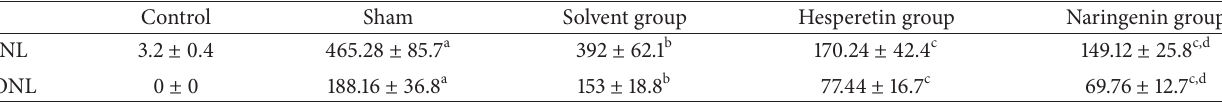
Table 2: Number of tunel positive cells in the retina.